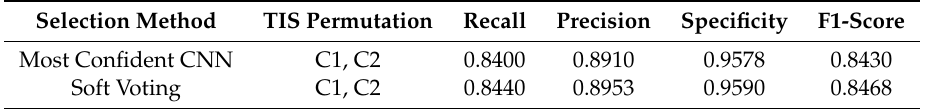
Table 12. Pose recognition results achieved using permutations of two corner TISs with three methods of prediction